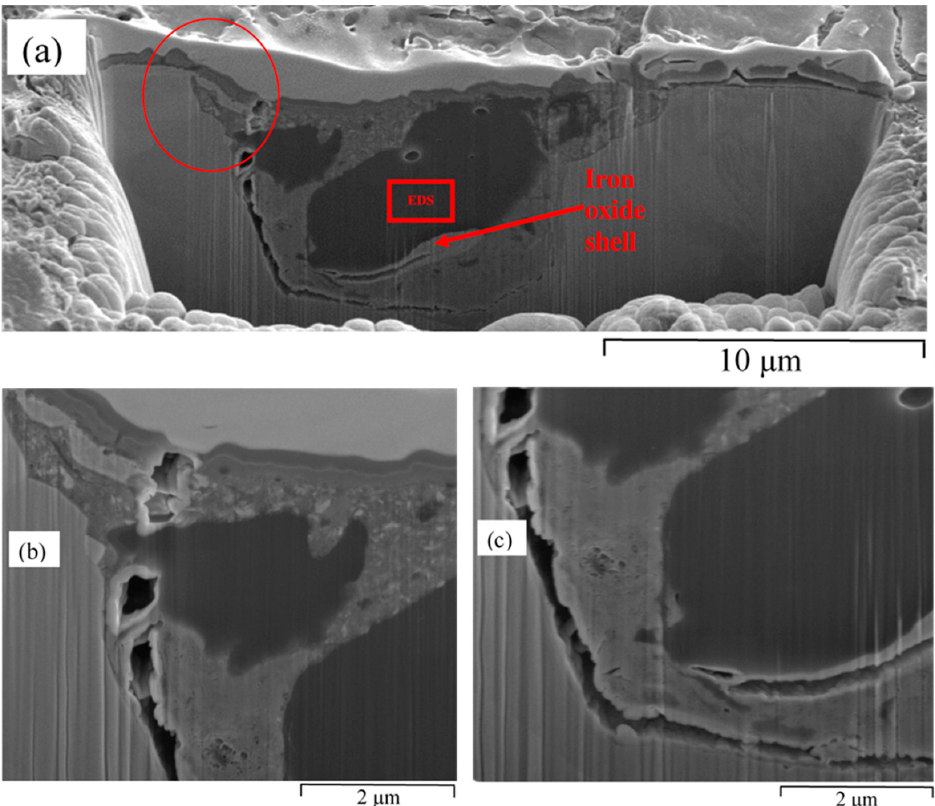
Figure 14. FIB-SEM cross-section of specific features of carbon steel exposed to the pure culture of IRB in the inorganic medium (i.e., Postgate C without organic components) for 168 h: ( a ) an overview of the cross-section (the circled area marks undercutting pitting attack making its way back towards the outer surface, EDS was performed in the area in the rectangle), ( b ) a close up view of the undercutting pit, and ( c ) a close up view of the side walls of the pit where biofilm is loosely attached in this area allowing electrolyte transport.